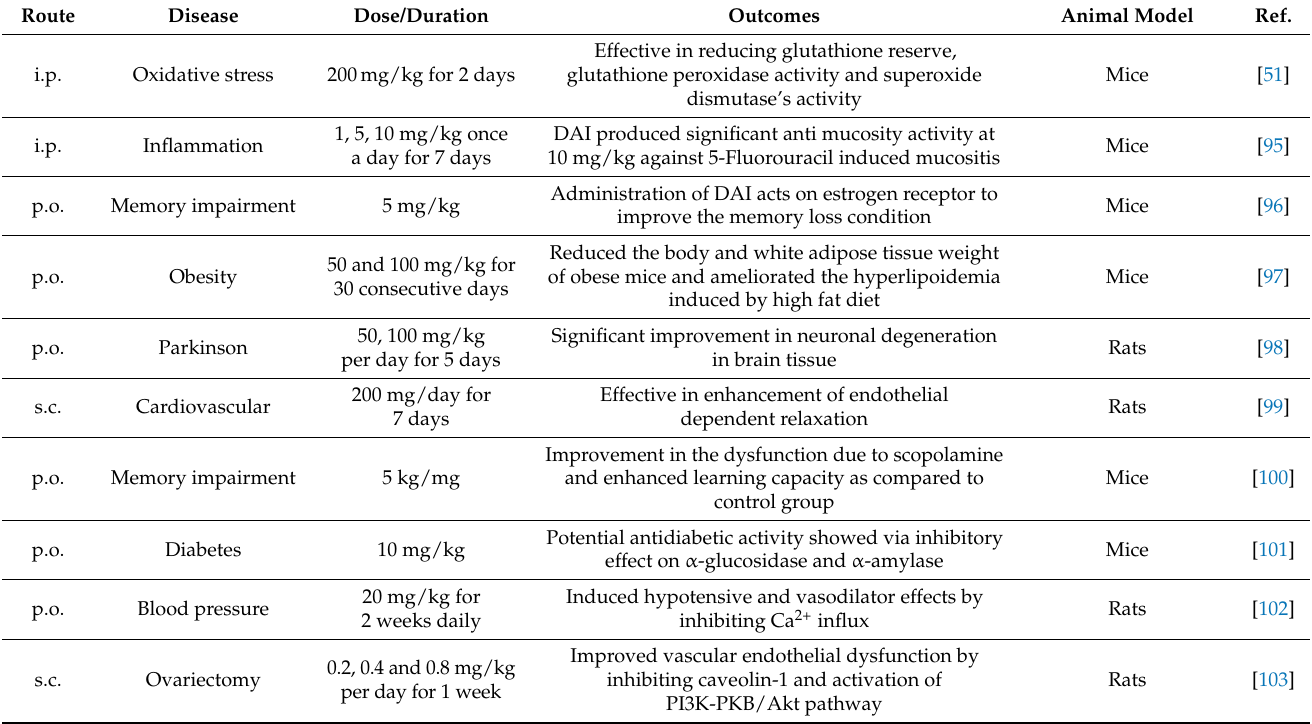
Table 2. Recapitulation of the outcomes of DAI’s pharmacological studies in several pre-clinical investigations for various disease